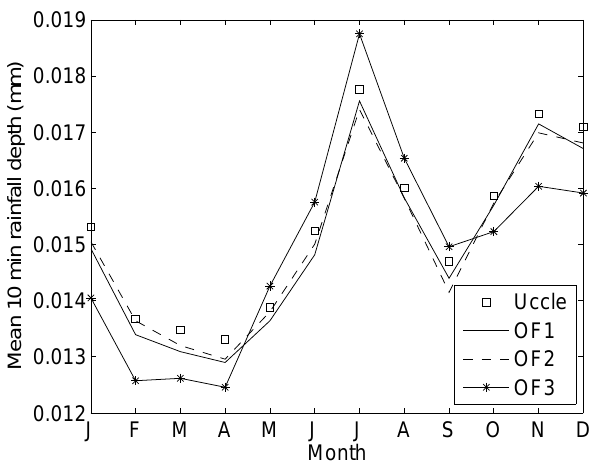
Fig. 12: Mean Percentage Error of different fits, averaged